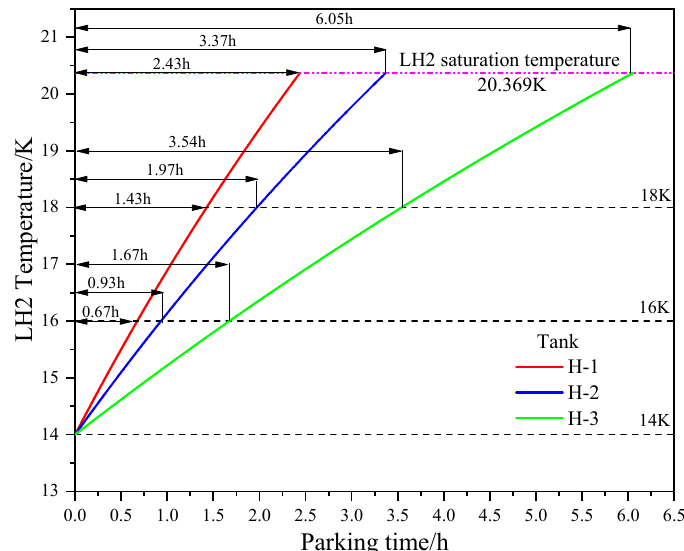
Figure 2. Temperature rise of densified LH2 parking.